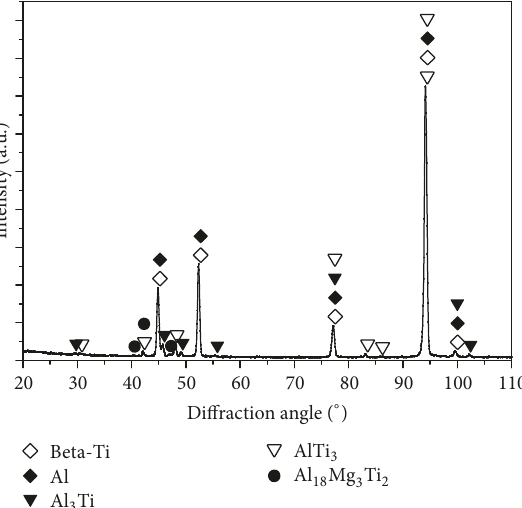
Figure 24: X-ray diffraction pattern of the weld metal.